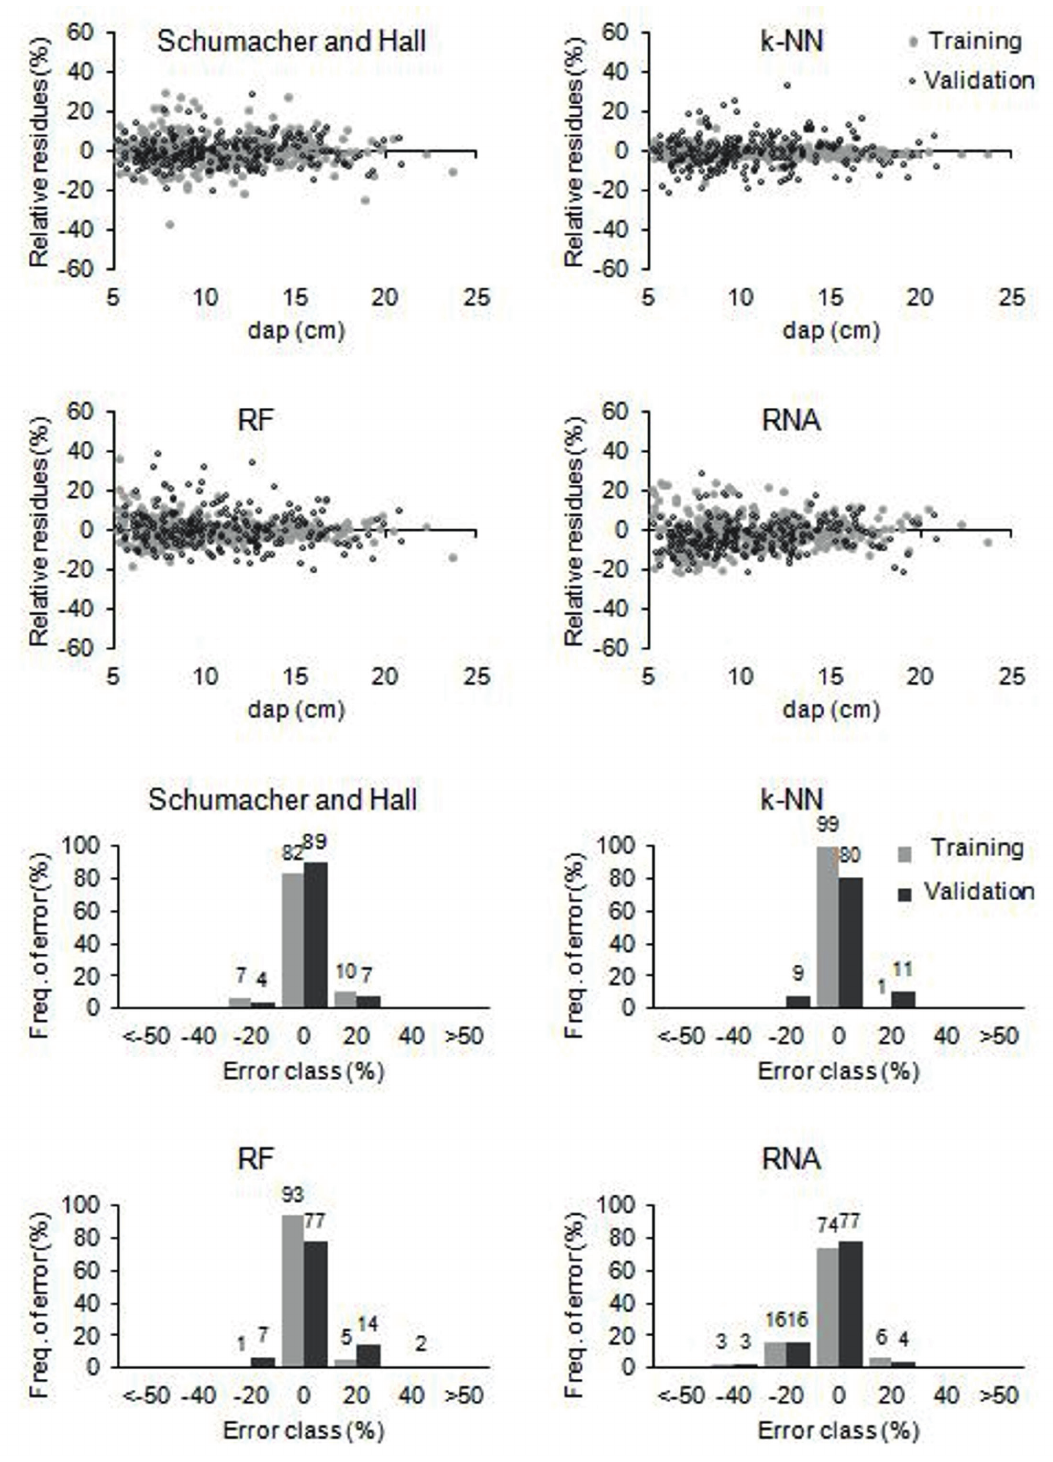
Figure 1 - Relative residues dispersion and frequency of percentual residues by error class for estimation of total volume in function of dap and total